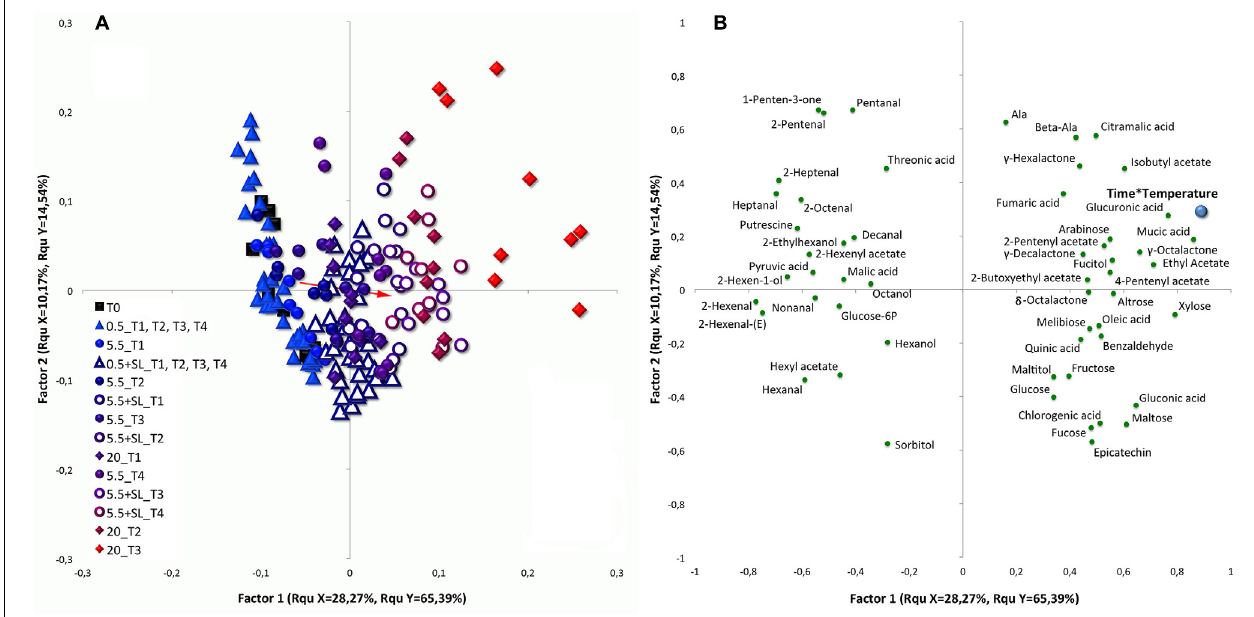
FIGURE 5 | Score (A) and loading (B) plots of a PLS-DA analysis performed with the whole dataset, including cold storage and shelf-life (SL) experiments together. The identified compounds were used as predictor variables and cumulative temperature (Time ∗ Temperature, see section “Statistical Analyses” for additional information) was employed as response variable. Filled black squares were used depicting samples at harvest (T0). Filled and empty triangles represent peaches under and after cold storage at 0.5 ◦ C (up to 4 weeks), respectively (0.5 ◦ C; 0.5 ◦ C + SL). Filled and empty circles were used to color fruit under and after storage at 5.5 ◦ C (up to 4 weeks), respectively (5.5 ◦ C; 5.5 ◦ C + SL). Control fruit (20 ◦ C, up to 3 weeks) were drawn as filled diamond. Colors from light blue to intense red were used to depict samples (T0 excluded) depending on their specific “Time ∗ Temperature” value. Important features have been filtered using VIP (Variable importance